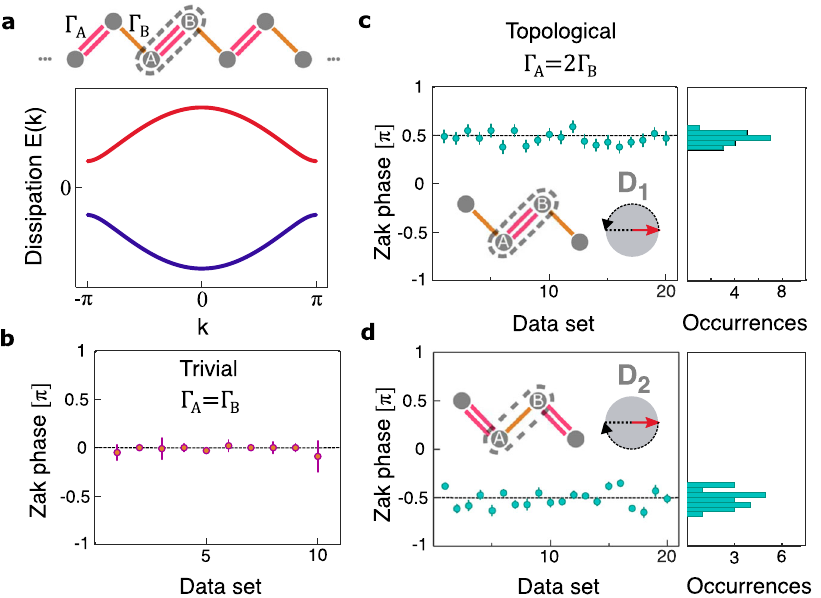
Fig. 3 | Measuring the geometric Zak phase in a dissipative SSH model using dissipative Bloch oscillations. a Schematic diagram of an SSH lattice with two different couplings Γ A =2 Γ B together with its associated dissipation bands. Since the interactions among the constituent elements are arising from the corre- sponding dissipators, these bands represent relative gain/decay rates, with the upper-band Blocheigenstates experiencing relative gain while the ones associated with the lower band decay faster. b – d Experimentally measured Zak phases under variouscouplingconditions.Atrivialcouplingbetweenthelatticesites Γ A = Γ B leads to a zero Zak phase b . On the other hand, when the intercell and intracell